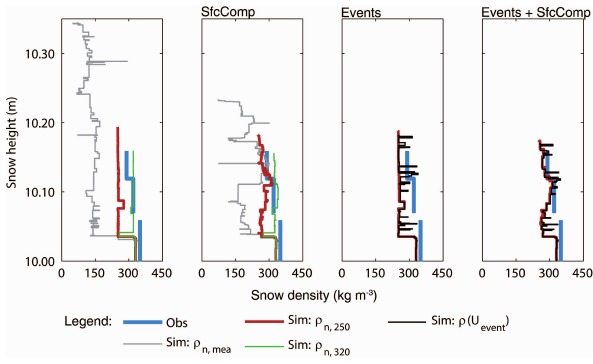
Fig. 7. Snow density profiles on 10 December 2008 as simulated with SNOWPACK using all combinations of parameterizations de- scribed in Table 2 and as observed at Concordia research station (thick, light blue line). The snow height of the observed profile is adjusted to the top of the event-driven simulation with wind com- paction (“ ρ(U event ) + SfcComp”) but note that the density of the topmost centimetre was not recorded in the field. The leftmost panel shows simulations where the initial snow density was either mea- sured or fixed and the snow added at the time of precipitation. The second panel from the left shows the same simulations but account- ing for surface compaction due to wind through Eqs. (2) and (3). In the third panel snow density was initialized at 250kgm − 3 or ac- cording to Eq. (1) and snow was deposited during events. In the rightmost panel surface compaction was additionally accounted for. Colours indicate the initial snow density as described in the